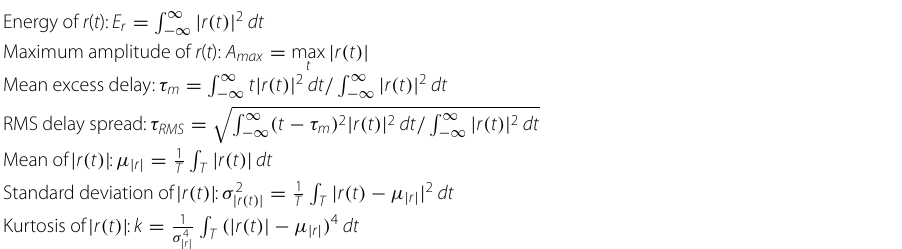
Table 2 Seven typical SP-based parameters [19] Energy of r ( t ): E r =